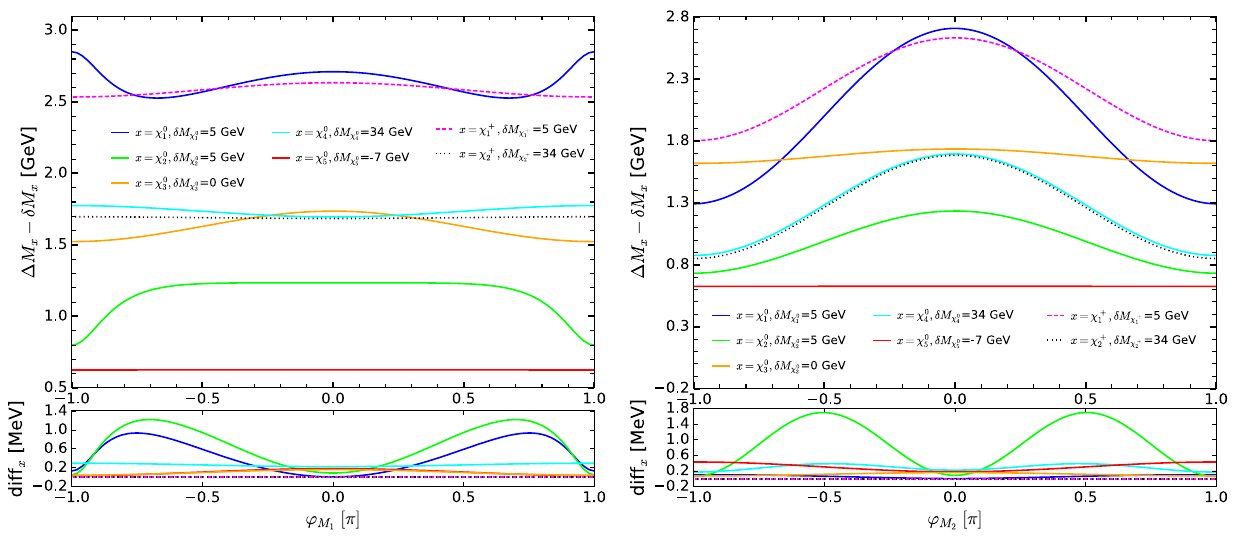
Fig. 10 Scenario1: Upper: Loop corrections to the electroweakino masses, (cid:20) M x (see text, for the definition), x = ˜ χ 0 j = 1 , 2), as a function of ϕ M